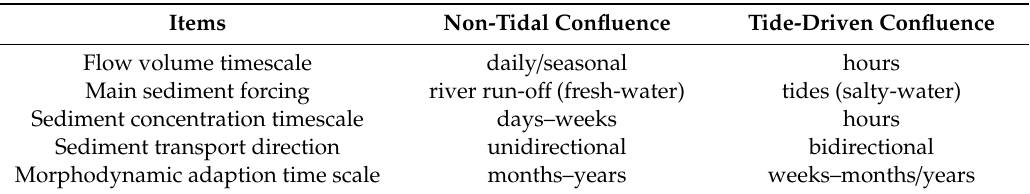
Table 1. Comparison of the main characteristics between a tidal and non-tidal confluence.